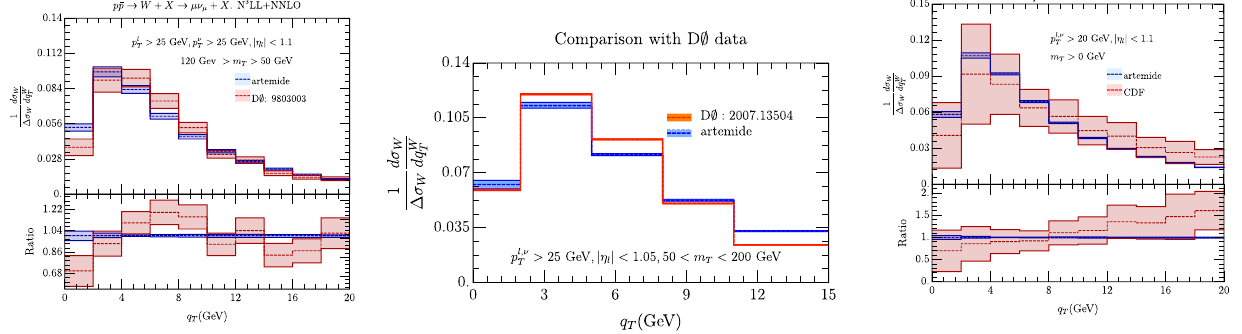
√ s = 1 . 8 TeV [7] and